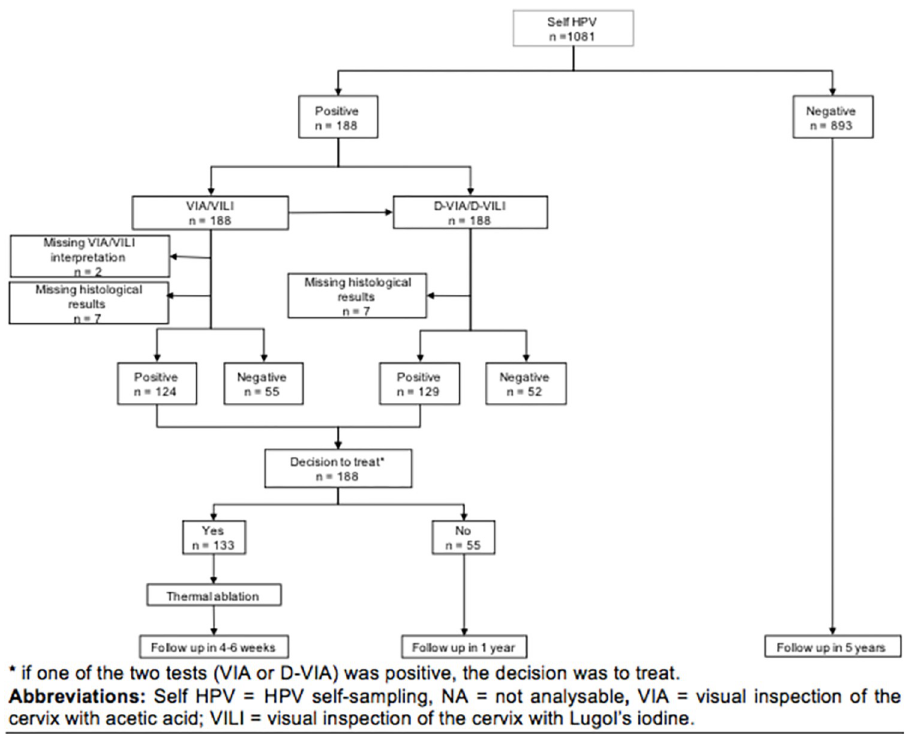
Fig 2. Flowchart of the study. � if one of the two tests (VIA or D-VIA) was positive, the decision was to treat. Abbreviations: Self HPV = HPV self-sampling, NA = not analysable, VIA = visual inspection of the cervix with acetic acid; VILI = visual inspection of the cervix with Lugol’s